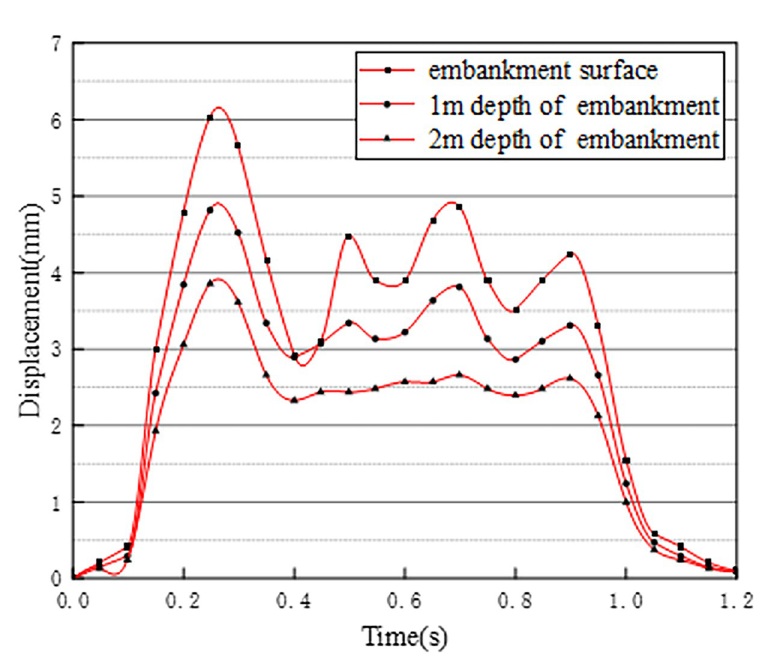
Fig 17. Displacement time history curves at different depths.